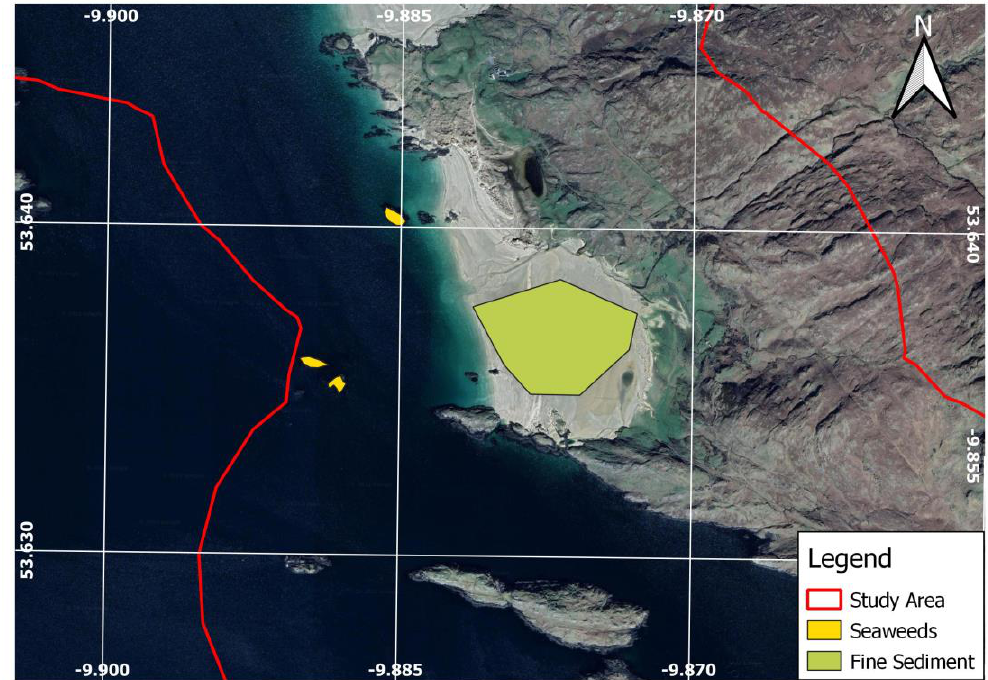
Figure 2 . Example of different classes training and validation